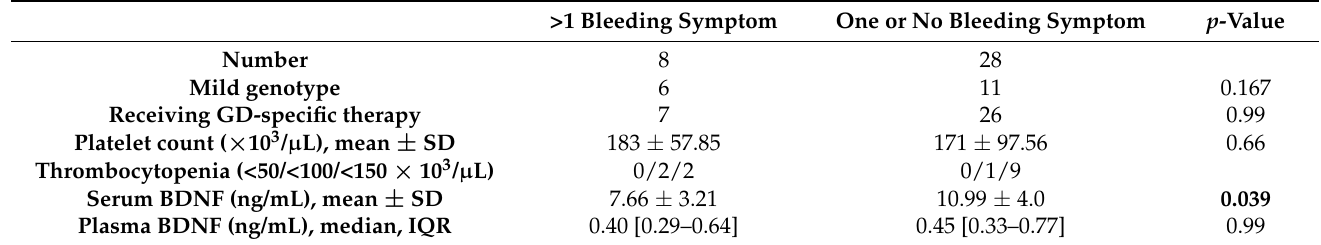
Table 3. Comparison of patients with more than one bleeding symptom to those with one or no bleeding